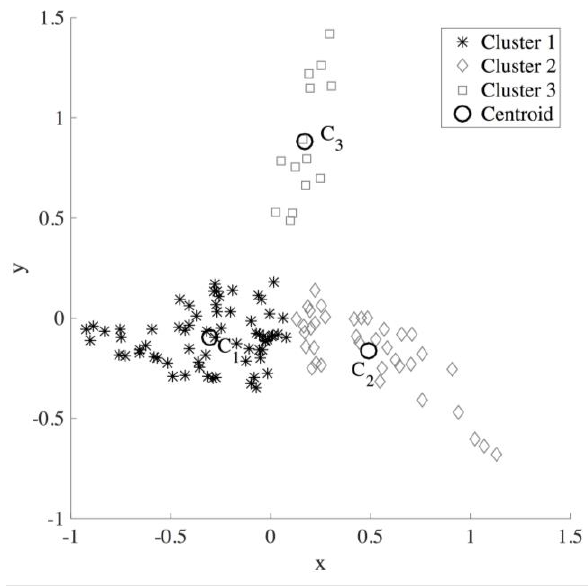
Figure 2 K-means graph. Each point in this Cartesian plane represents a student. Points labelled C 1 , C 2 , and C 3 are the